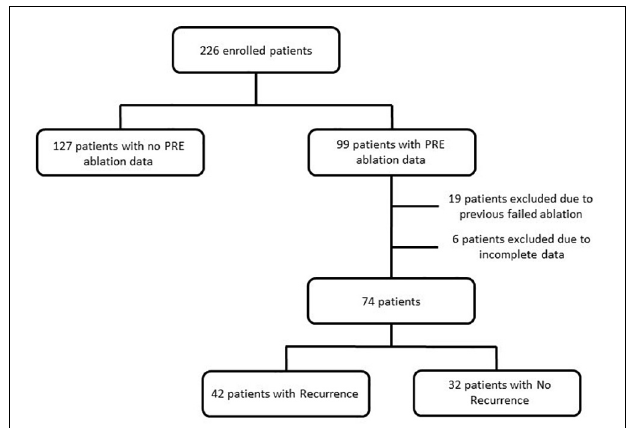
FIGURE 1 | Flow diagram describing the source